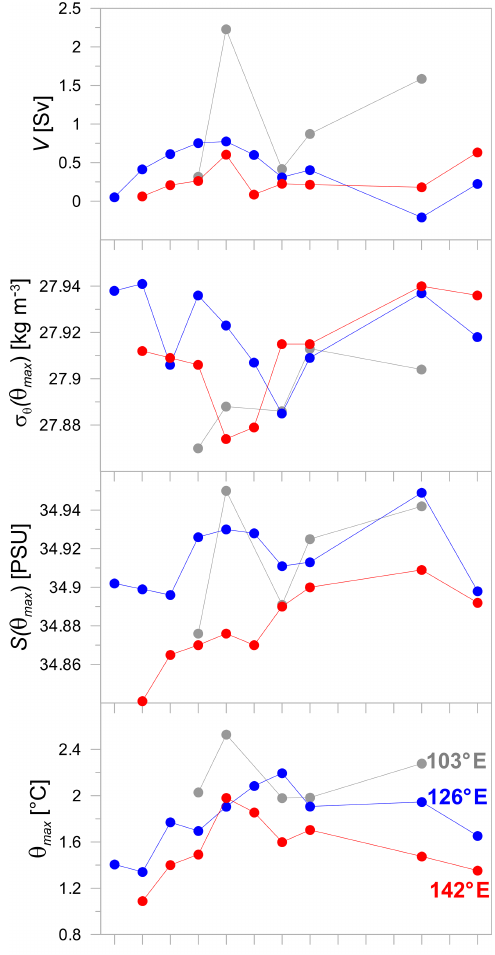
Figure 10. Interannual variability of the maximum temperature θ max and the related values of salinity S(θ max ) , potential density anomaly σ θ (θ max ) , and volume flow rate V on the cross-slope tran- sects at 103, 126, and 142 ◦